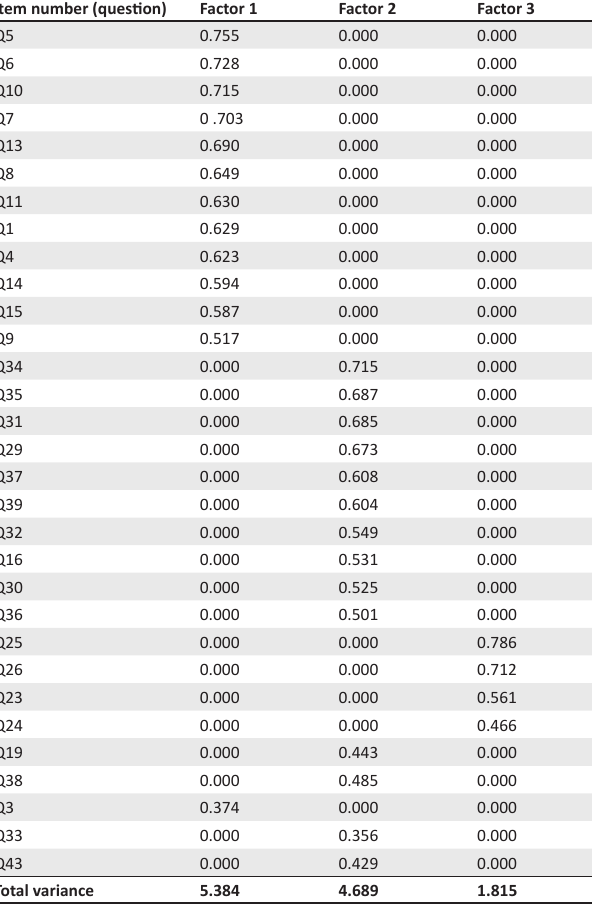
TABLE 7: Scree plot. TABLE 8: Quartimin factor rotation.